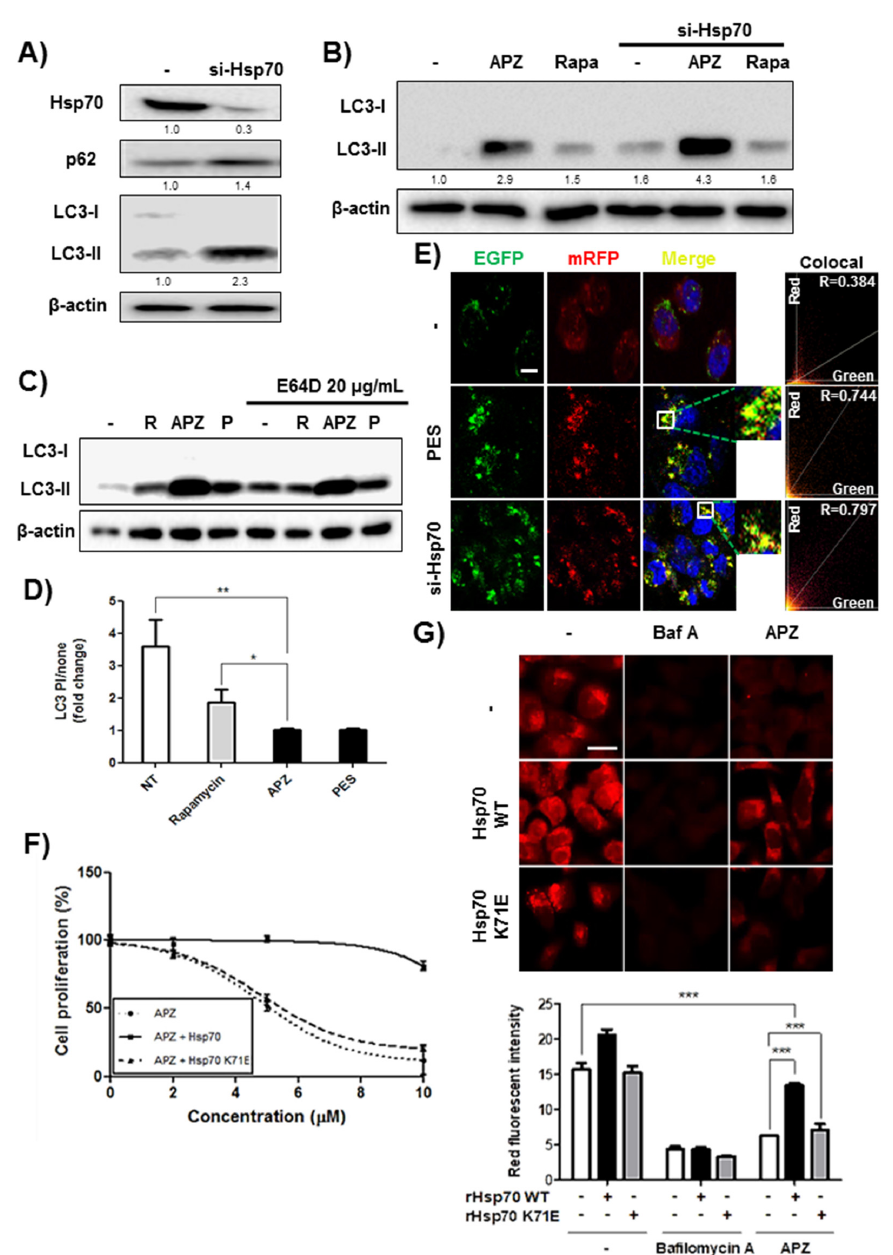
Figure 6. Validation of Hsp70 as a protein target of APZ. ( A ) Immunoblots of p62, and LC3 in HeLa cells after 24 h of Hsp70 knockdown (10 nM). ( B ) Immunoblot of LC3 upon compounds treatment after Hsp70 knockdown (10 nM). Autophagy induction by APZ significantly increased after Hsp70 knockdown, but rapamycin did not have this e ff ect. ( C ) LC3 conversion increased after E64D treatment for 24 h. E64D pretreatment did not a ff ect APZ-induced LC3 conversion. ( D ) Quantification of data shown in b. Ratio of LC3-II in E64D-treated cells to that in untreated cells. Values represent means ± SEM of fold-changes in cotreatment relative to levels in untreated cells; n = 3. * p < 0.05, ** p < 0.01, * p < 0.05. ( E ) Autophagic flux in HeLa cells as measured by mCherry-GFP LC3 after si-Hsp70 and 2-phenylethynesulfonamide (PES, 5 µ M) treatment. Representative merged-channel images; scale bar, 10 µ m. Pearson coe ffi cient for the colocalization analysis is shown. ( F ) Genetic Hsp70 overexpression reduced antiproliferative activity of APZ. Values represent means ± SE; n = 4. Wildtype EGFP-Hsp70 or K71E EGFP-Hsp70 vectors (200 nM) were transfected into HeLa cells for 4 h. APZ was administered at the indicated concentrations for 48